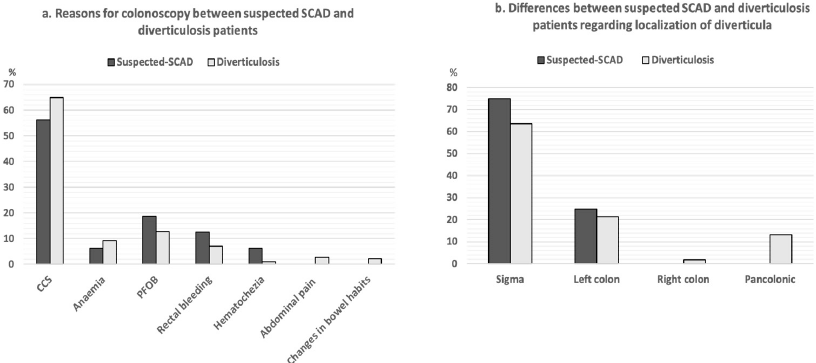
Figure 1. ( a ) Reasons for colonoscopy: comparison of patients with suspected SCAD and patients with colonic diverticulosis; ( b ) localization of diverticula: comparison between patients with suspected SCAD and patients with diverticulosis. SCAD: segmental colitis associated with colonic diverticulosis, CCS: colon cancer screening, PFOB: positive fecal occult blood.